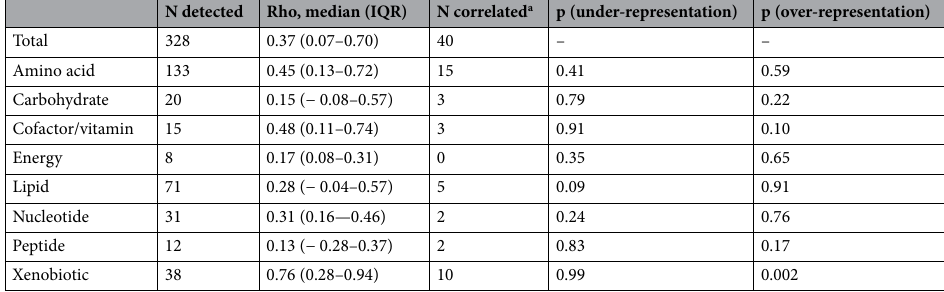
Table 3. Number of compounds detected in ≥ 3 plasma and CSF samples, and number that were significantly correlated after FDR correction, by class. a q < 0.05 after Benjamini–Hochberg